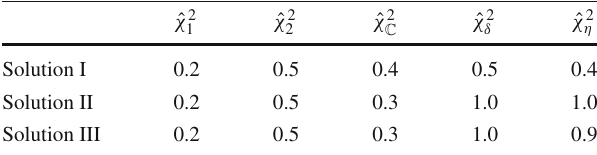
Fig. 3 Real (top) and imaginary (bottom) parts of the scalar-isoscalar partial wave in the first Riemann sheet of the complex- s plane, within the applicability region of GKPY/Roy equations. There are actually three surfaces on each plot: one for the central value, one for the upper uncertainty and another one for the lower uncertainty band. Note that the behavior of the parameterization is smooth and the uncertainties are small compared to the typical scale of the analytic structures, even deep in the complex plane. We plot solution I, since solutions I, II and III are almost identical in this region Table 4 Results in terms of ˆ χ 2 of the S0 solutions I, II and III in different